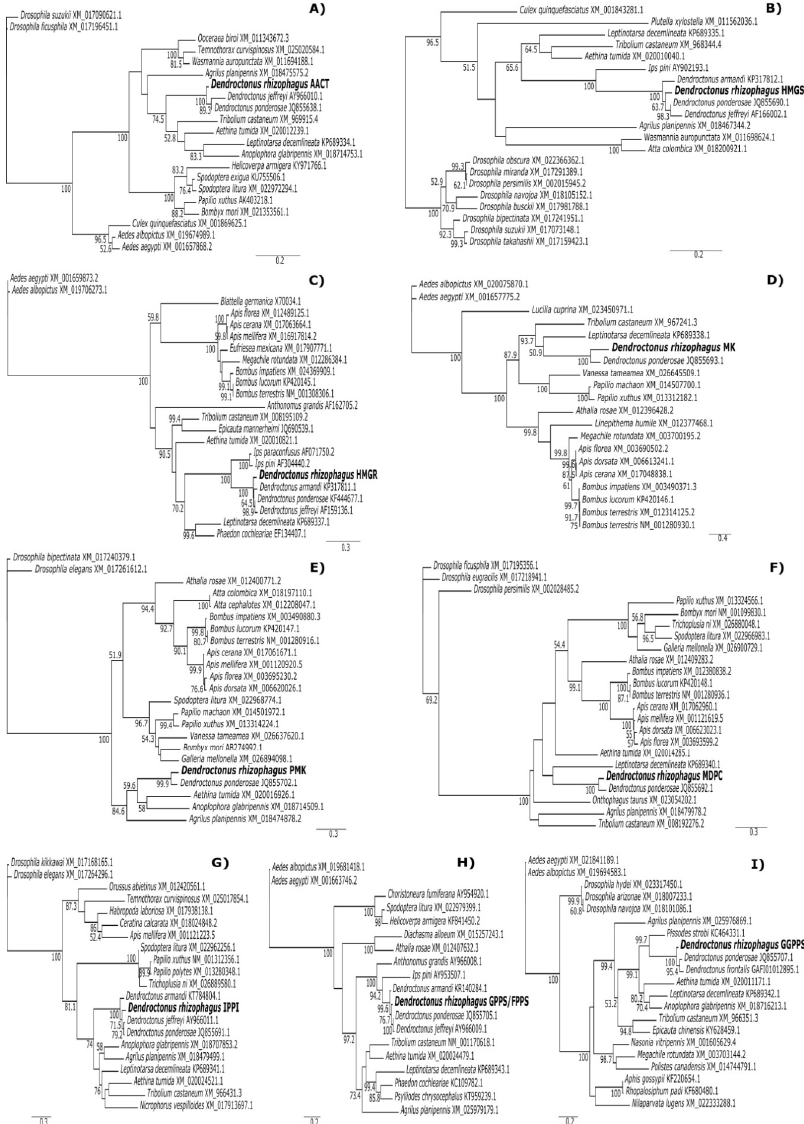
Figure 1. Maximum likelihood trees of MVA pathway genes based on the amino acid sequences of D. rhizophagus along with insect sequences obtained from GenBank. Bootstrap values after 1000 replicates are shown at nodes. ( C ) HMGR used the model JTT (+G +I +F) with an estimated proportion of invariable sites (I) of 0.073 and a gamma parameter (G) of 0.575 (−lnL = 14615.13). ( A ) AACT (I = 0.230, G = 0.929, −lnL = 5343.20); ( B ) HMGS (I = 0.242, G = 1.166, −lnL = 6933.67); ( D ) MK (I = 0.075, G = 1.464, −lnL = 9730.43); ( F ) MDPC (I = 0.221, G = 1.139, ‐lnL = 8370.35); ( H ) GPPS/FPPS (I = 0.068, G = 1.253, −lnL = 8378.21); and ( I ) GGPPS (I = 0.253, G = 1.001, −lnL = 5004.36) used the model LG (+G +I +F); however, ( G ) IPPI (I = 0.150, G = 1.240, −lnL = 5622.99) and ( E ) PMK (I = 0.160, G = 1.459, −lnL = 3924.98) used the model LG (+G +I).